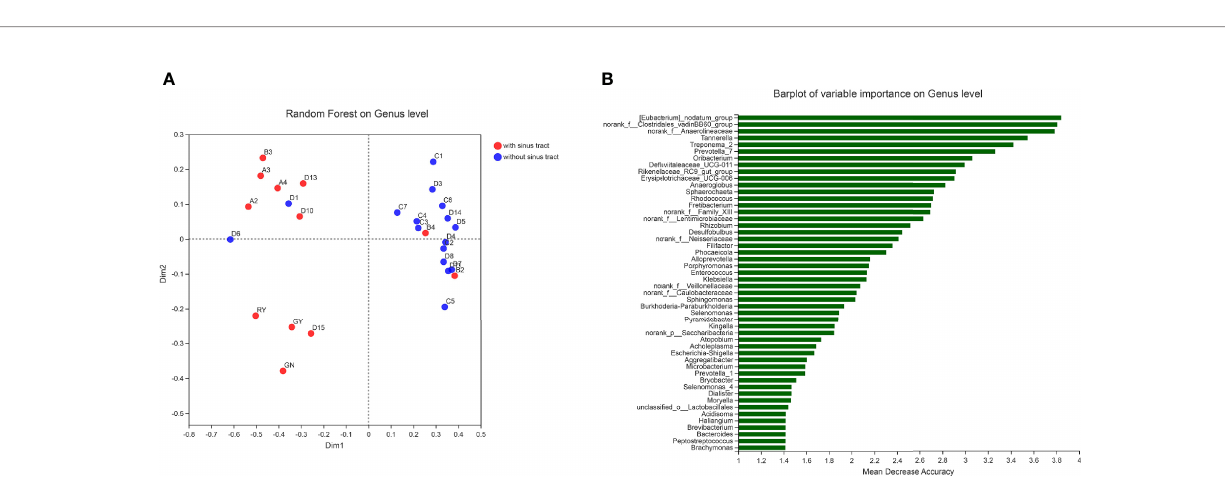
FIGURE 6 | Classi fi cation of samples by Random forest analysis. (A) sample distribution in the Random forest model; (B) the genera with the highest importance scores in the Random forest